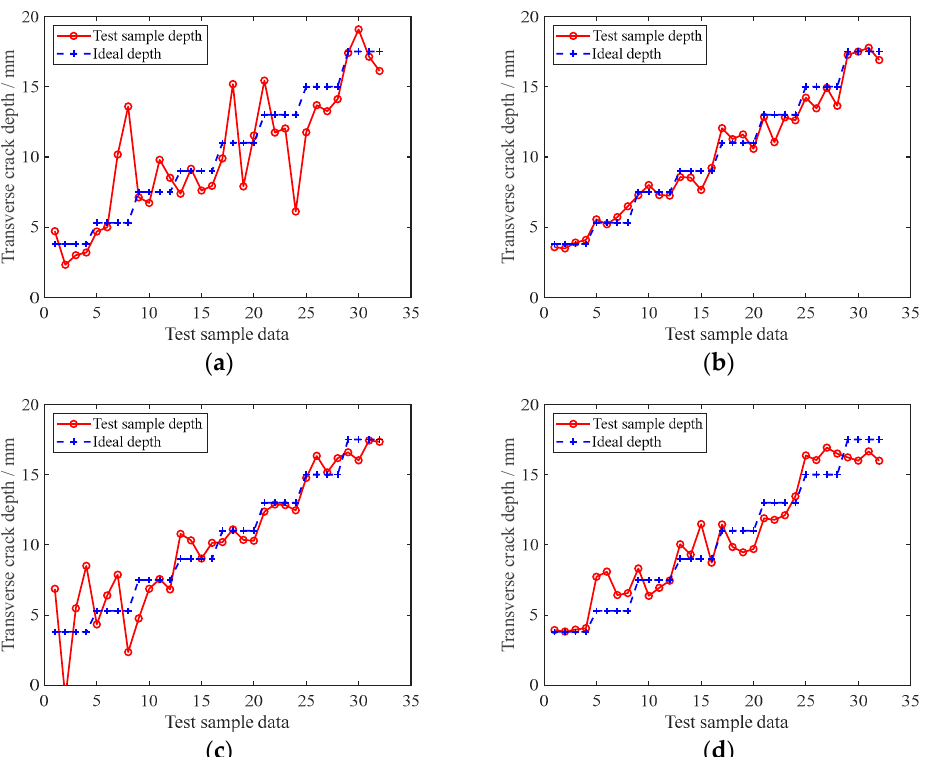
Figure 20. Test Set I test results for each path model; ( a – d ) are the paths of E1–R2, E2–R4, E3–R1, and E4–R4, respectively.